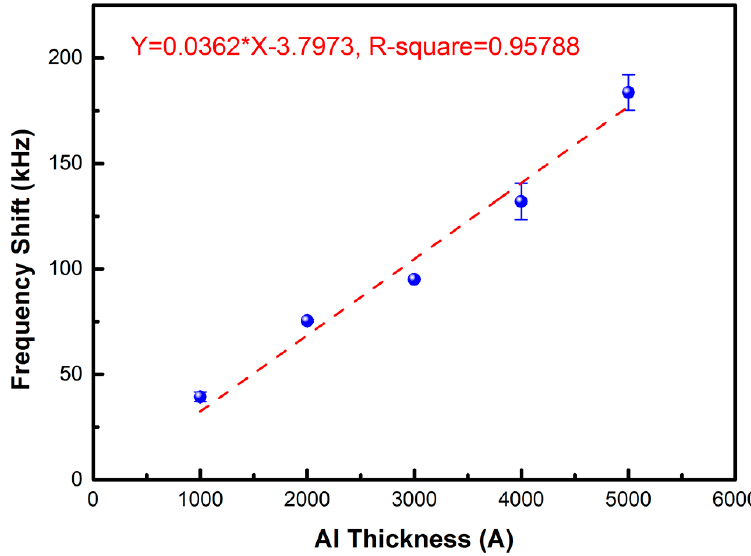
Figure 6. The frequency shifts of the FPW device with five different Al mass loadings.